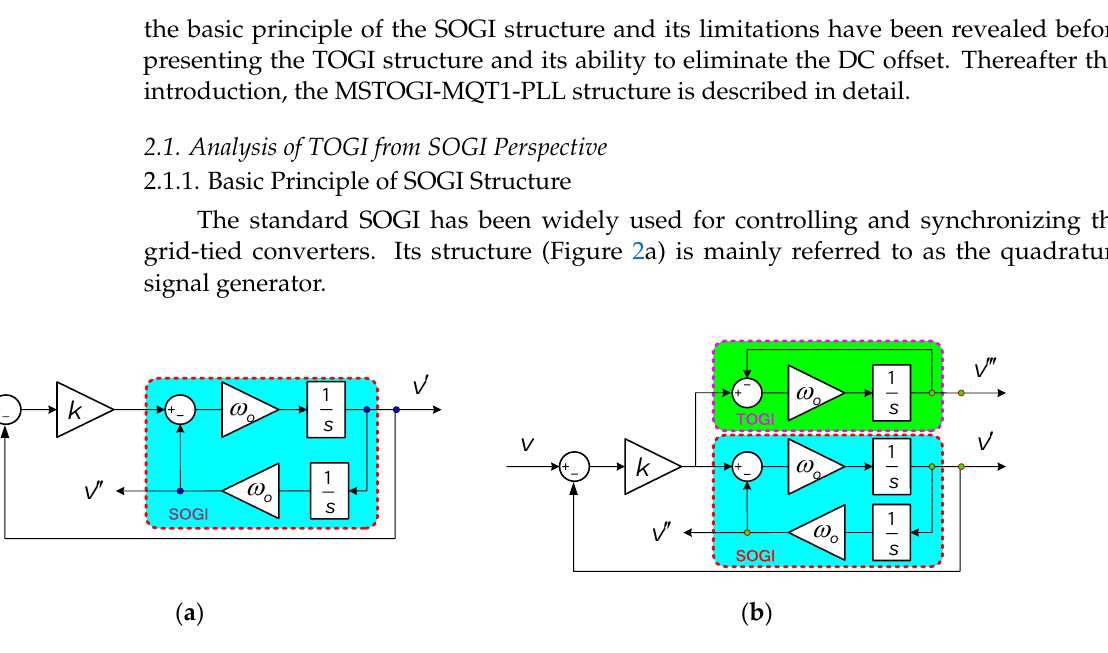
Figure 2. Block diagram of: SOGI structure( a ) and MSTOGI structure ( b ) [45]. Assuming that the resonant frequency ω o is equal to that of the main grid (314 rad/s), and taking into account the orthogonal output signals v (cid:48) and v (cid:48)(cid:48) , the closed-loop transfer functions (CLTF) of SOGI are given by (1) and (2), respectively [43].